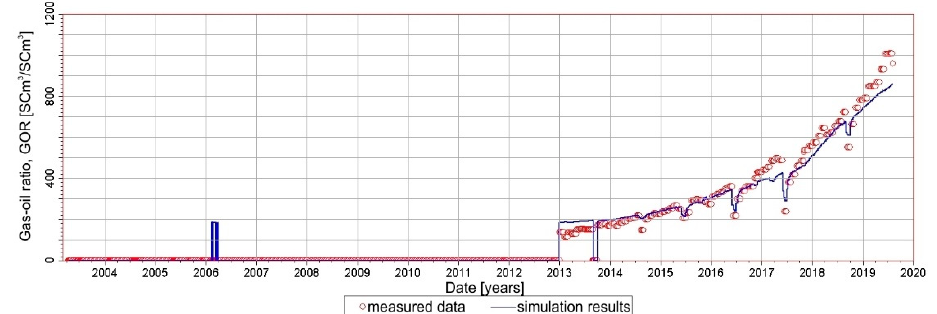
Figure 11. Bottom-hole pressure variation at well A-7H.